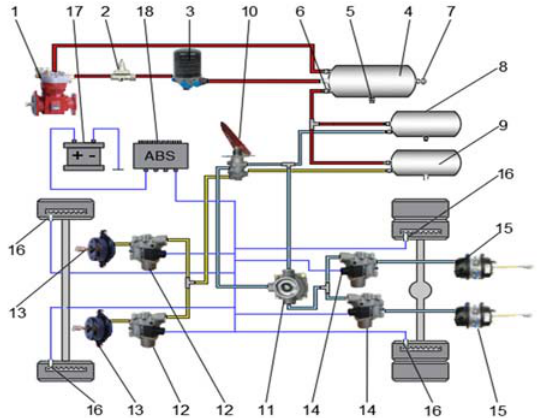
Figure 1. Schematic diagram of the pneumatic anti ‐ lock braking system (ABS). 1 ‐ air